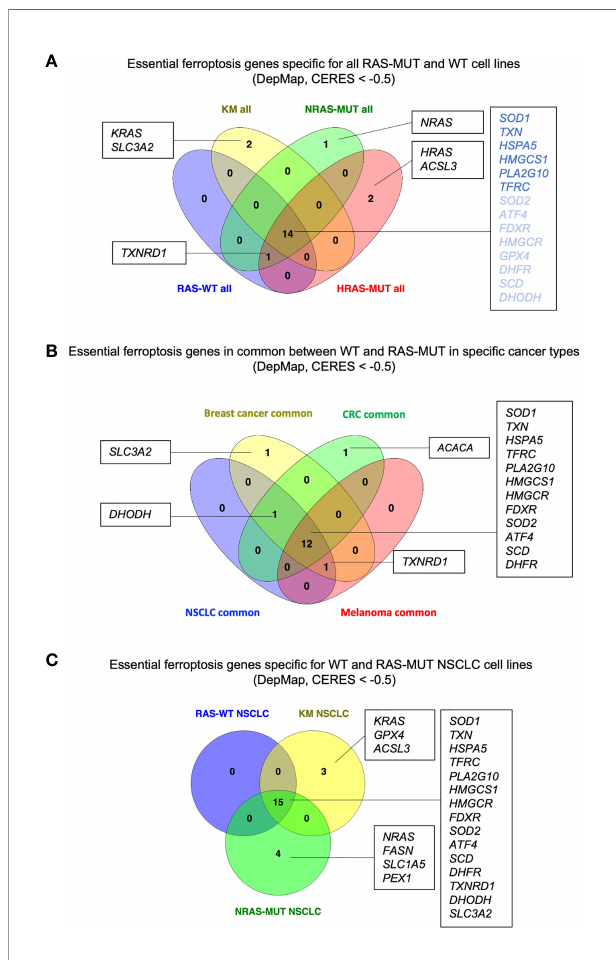
FIGURE 2 | RAS- and cancer type-independent/dependent ferroptosis vulnerabilities. (A) Venn diagram summarizing the genes with CERES scores lower than -0.5 in cancer lines grouped for RAS mutation. RAS-independent genes with overall median CERES lower than -1 are indicated in dark blue. (B) Venn diagram for the RAS-independent genes with CERES scores lower that -0.5 in breast cancer, colorectal cancer (CRC), non-small cell lung cancer (NSCLC) and melanoma cell lines. (C) Venn diagram showing the ferroptosis genes with CERES score lower than -0.5 in NSCLC cell lines of the indicated genotype. Diagrams created using Venny 2.1